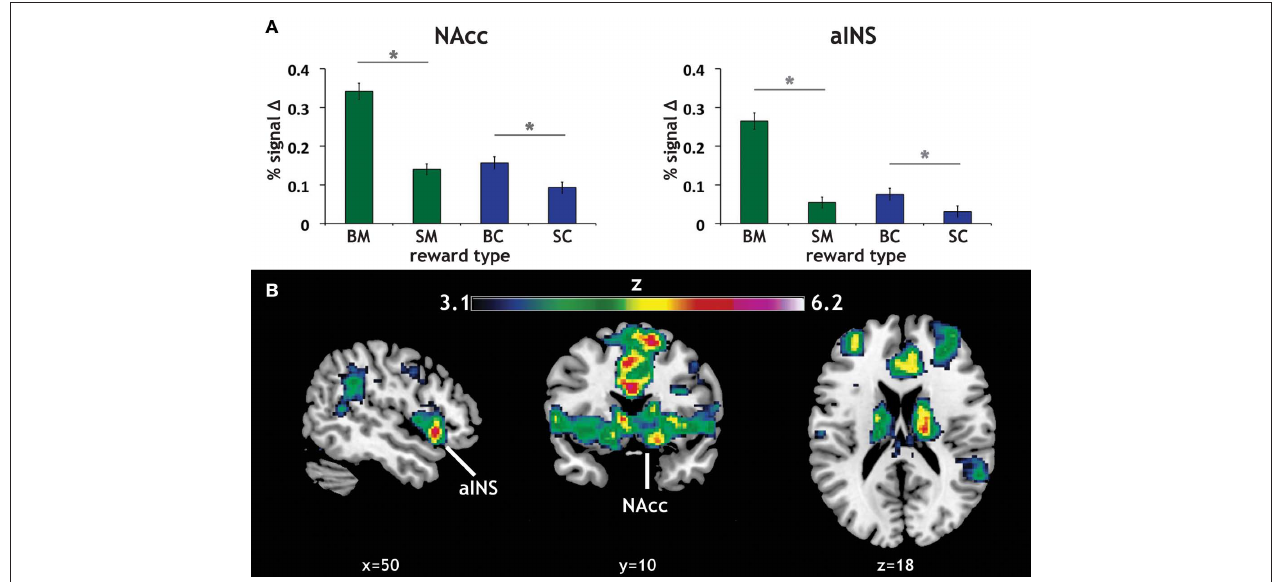
represent SE of the mean (SEM). Stars represent significant paired comparisons ( p < 0.05). (B) Repeated-measures 2 × 2 ANOVA of reward anticipation. To determine whether there was a significant modality (money, candy) by magnitude (big, small) interaction in our fMRI data, a 2 × 2 repeated-measures ANOVA of the same anticipation contrasts was run. The statistical map here displays the z -scored F statistics for that interaction. There were significant clusters in both NAcc